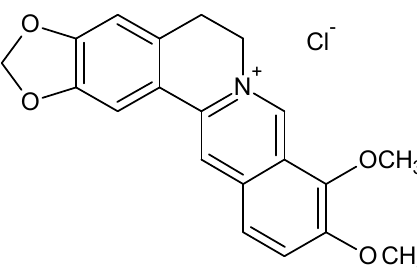
Figure 8. Chemical structure of the berberine derivative—berberine chloride salt, containing a protoberberine skeleton and nitrogen cation ion. The positively charged berberine molecule possesses a